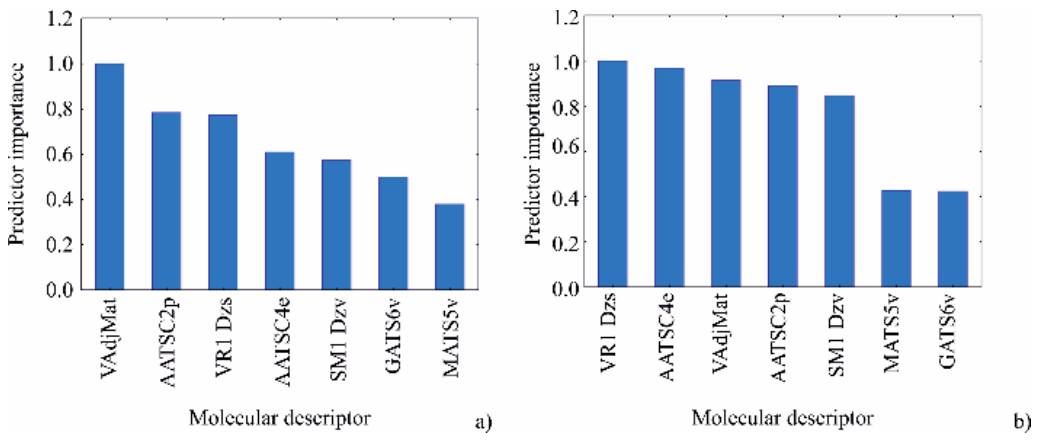
Figure 3. Predictor importance of the molecular descriptors on RI in 2019 ( a ) and 2020 ( b